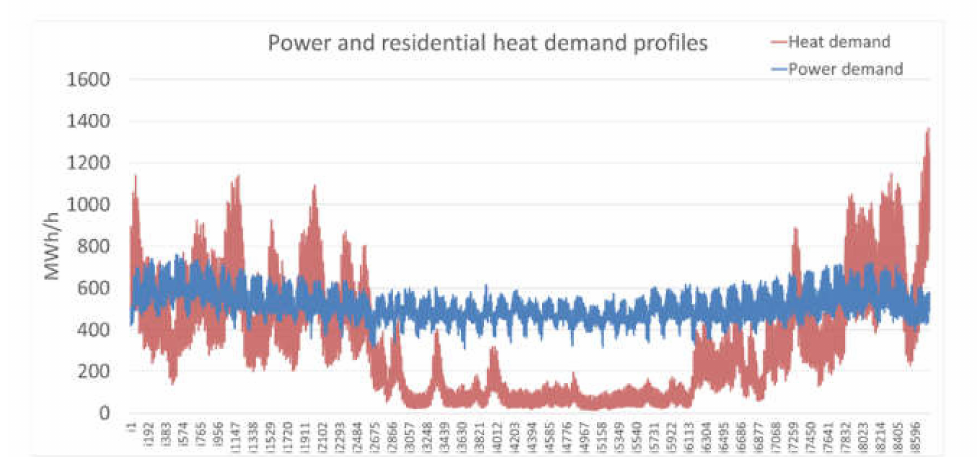
Figure 2. Estimated annual profiles for the power and residential heat demands for the BCR in 2050. X -axis units are the time steps, representing the hours of the year.